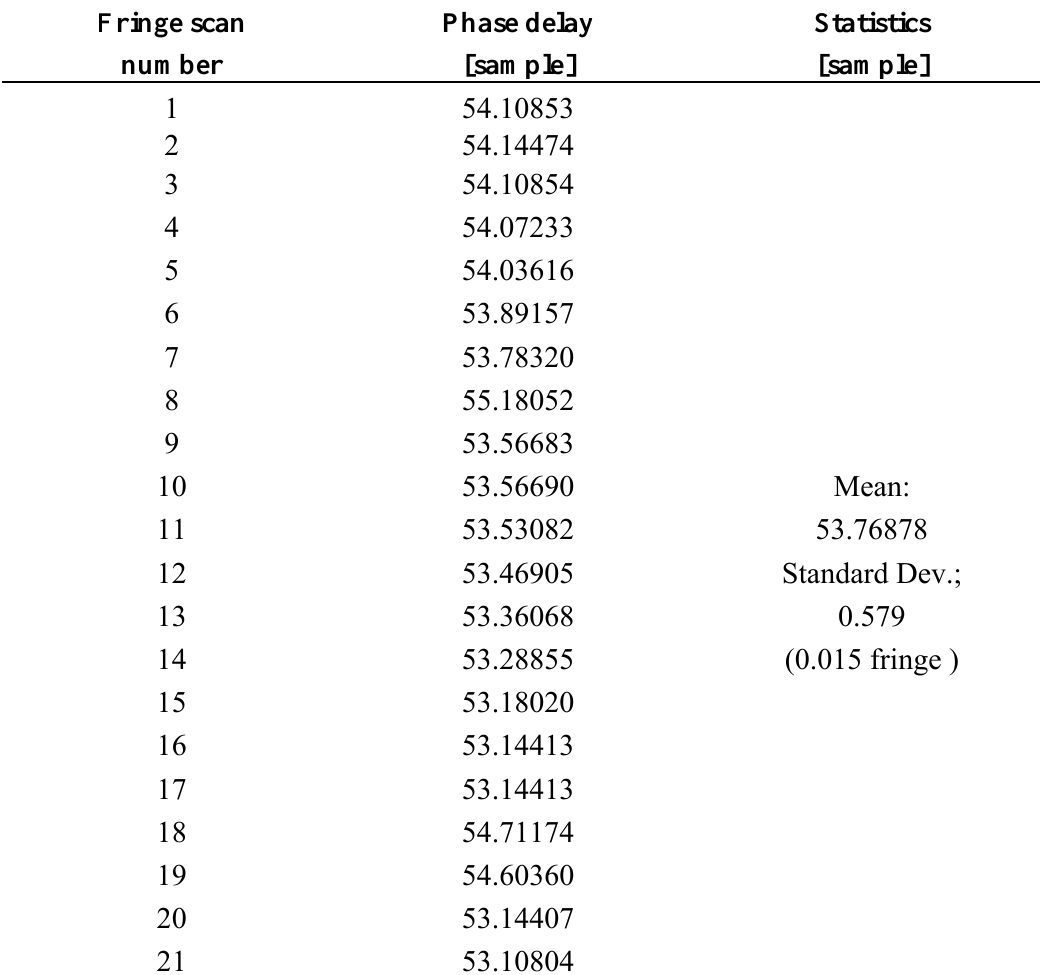
Table 1 . Phase Delay ΔΦ i of stability